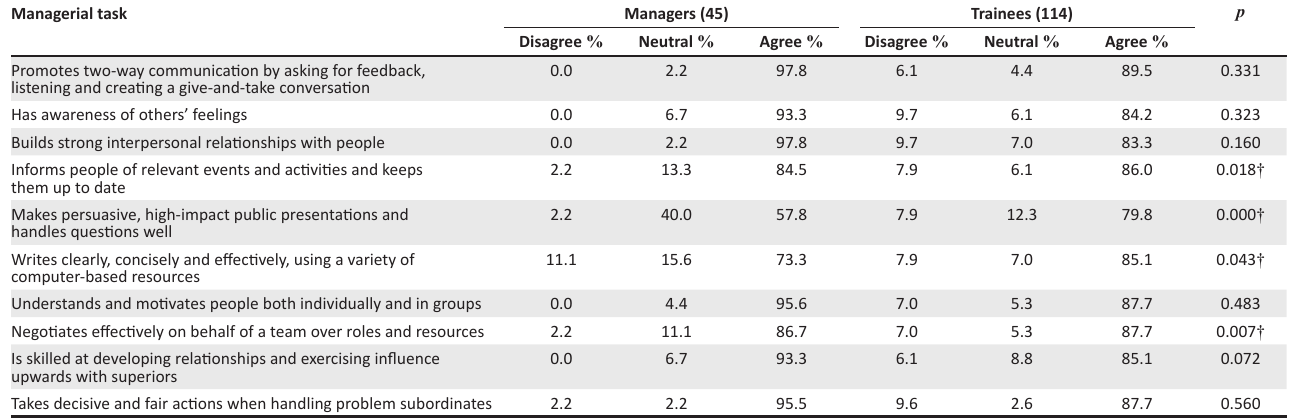
TABLE 4: Results for communication.